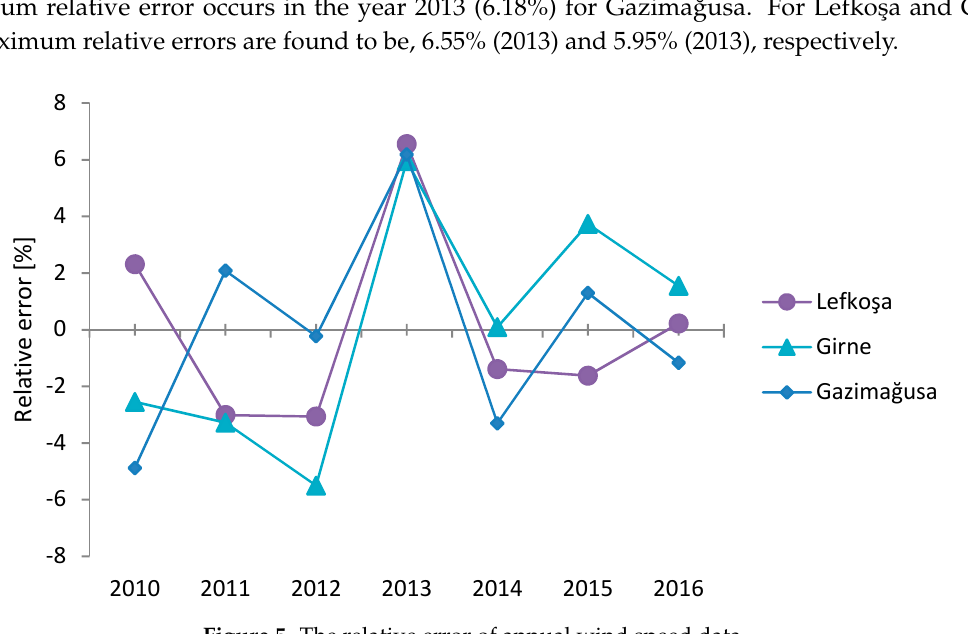
Figure 5. The relative error of annual wind speed data.